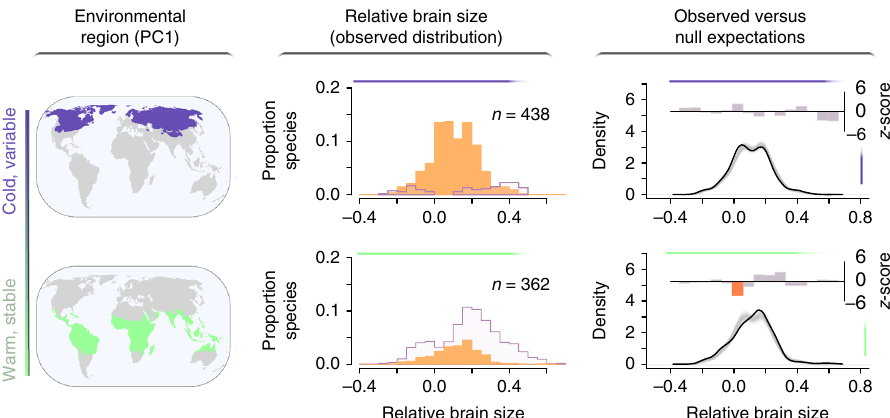
Fig. 2 The global distribution of brain size for migratory birds in relation to environmental PC1 (i.e., a metric of temperature variability and unpredictability). The observed distributions of relative brain size for 623 species (middle column, in orange) within two environmental regions (left column) are compared to null expectations (right column). The map regions colored in deep purple are those with the lowest values of environmental PC1 and are characterized by cold and variable temperatures; the regions in green, with high values of environmental PC1, are warm and stable 16 . Each observed distribution of relative brain size includes all migratory species with breeding distributions that overlap with the corresponding environmental region; the distribution of relative brain size for resident species that live year-round in each environmental region is included in outline for reference. Kernel density estimates of relative brain size for the observed sample of n migratory species that occur within each environmental region (solid black lines in right column) are compared to 10,000 null density estimates, each derived from n randomly sampled migratory species (1000 examples plotted as light gray lines). At 15 evenly spaced points across the full range of relative brain size values, empirically derived density estimates are compared to density estimates from the null samples; the height of bars in the third column depict z -scores from these comparisons. For relative brain sizes that were observed at a signi fi cantly higher than expected frequency within a given environmental region, bars are depicted in blue, those observed signi fi cantly less frequently are depicted in red, and those that do not differ signi fi cantly from null expectations are depicted in gray. Source data are provided as a Source Data fi le